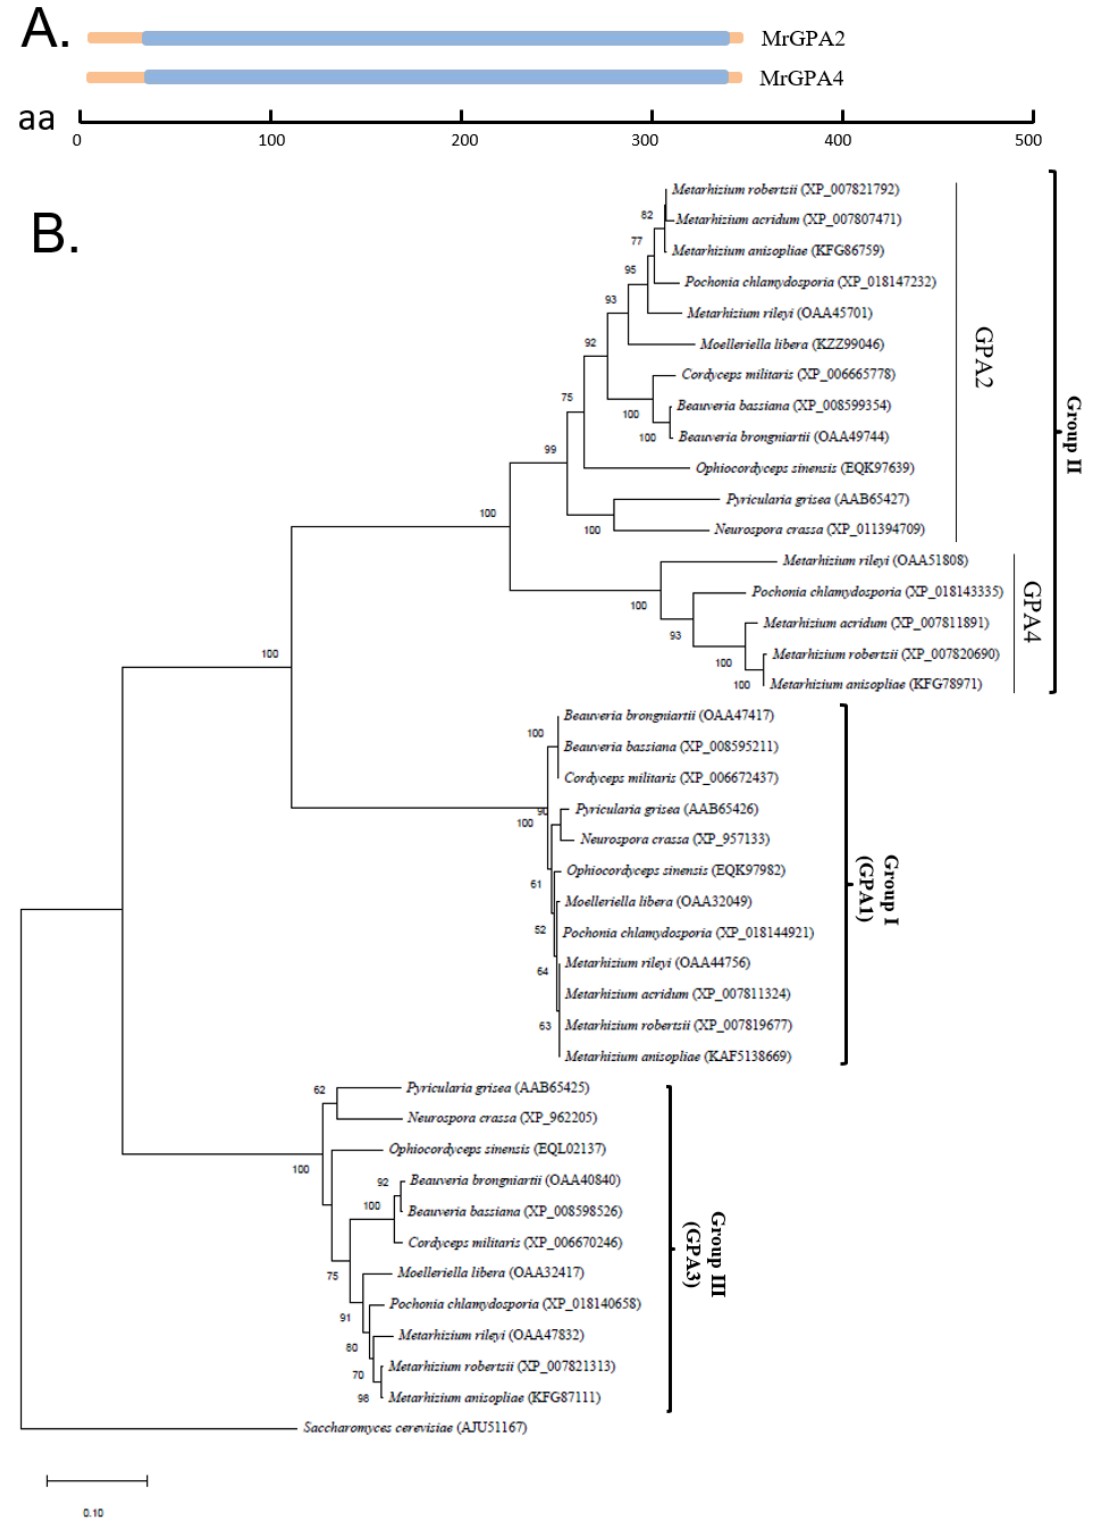
Figure 1. Phylogenetic analysis of four G-proteins in Metarhizium robertsii . ( A ) Conserved domain analysis of MrGPA2 and MrGPA4. The guanine nucleotide-binding domains of the GPAs are shown in blue. aa, amino acid. ( B ) Phylogenetic relationship analysis of four G-proteins in M. robertsii and their orthologs in different fungi by the neighbor-joining method. Four G-proteins of M. robertsii and their related proteins are given in brackets following each fungal